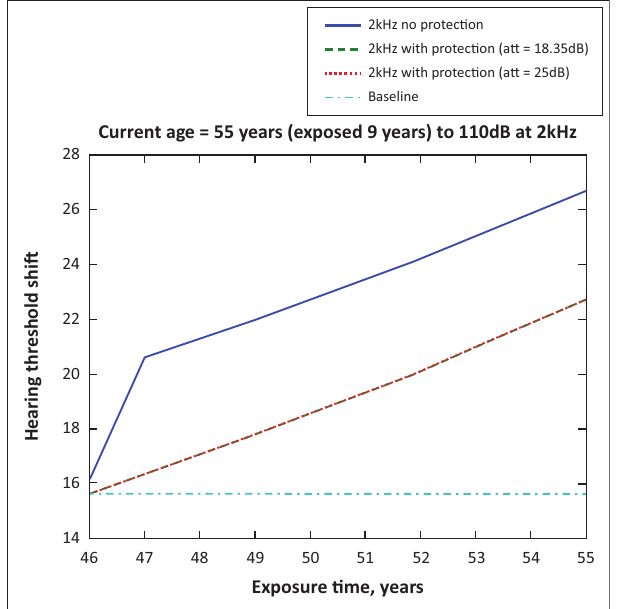
Source : Figure created using data from Moroe, N.F. (2018). Occupational noise-induced hearing loss in South African large scale mines: From policy formulation to implementation and monitoring . Doctoral thesis. Johannesburg: University of the Witwatersrand. FIGURE 12: Fifty-five years old at 2000 Hz with exposure levels of 110 dB.